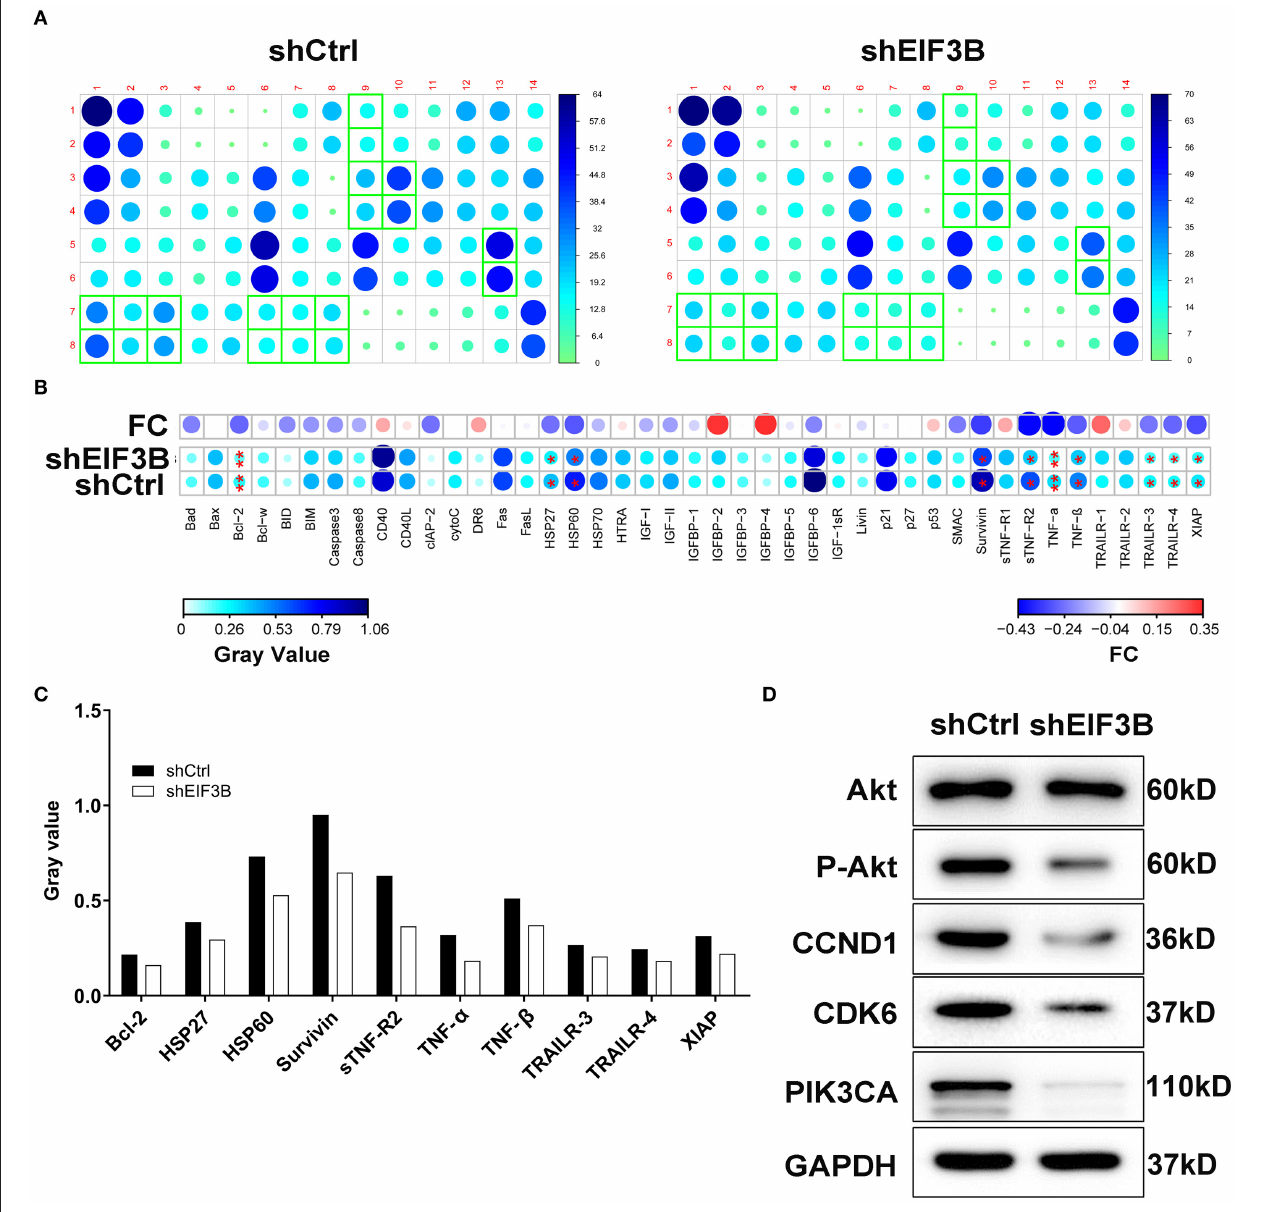
FIGURE 4 | The apoptotic molecular mechanism was investigated by Human Apoptosis Antibody Array. (A) The expression of apoptosis-related proteins in pancreatic cancer (PC) cells infected with shEIF3B was measured by enhanced chemiluminescence (ECL) with Human Apoptosis Antibody Array. The results circled in red indicated that the protein expression was up-regulated and P < 0.05. (B) Protein expression was presented in grayscale and visualized by R studio. (C) The expression levels of apoptosis-related proteins were analyzed in PC cells with shEIF3B. (D) The expression of Akt, p-Akt, CCND1, CDK6, and PIK3CA was detected by western blot in SW1990 cells of the shCtrl and shEIF3B groups. Results are presented as mean ± SD. * P < 0.05, ** P <